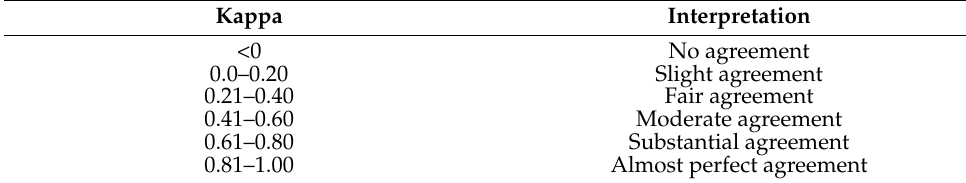
Table A1. Cohen’s kappa coefficient interpretation.